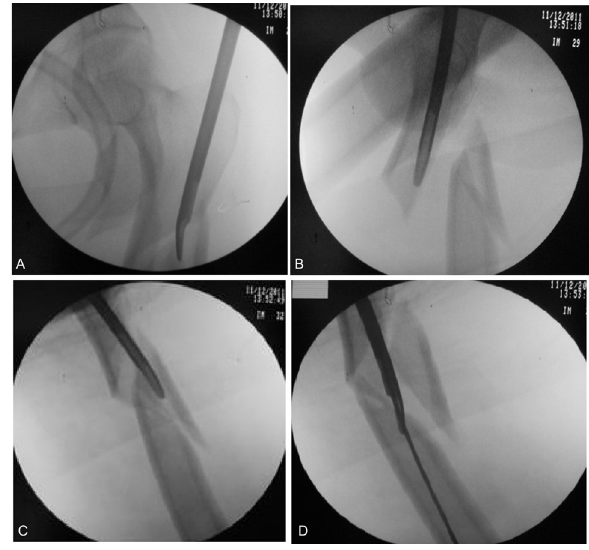
Figure 2. Using the internal reduction device to manipulate the proximal fragment aligning it with the distal fragment followed by passing the guide